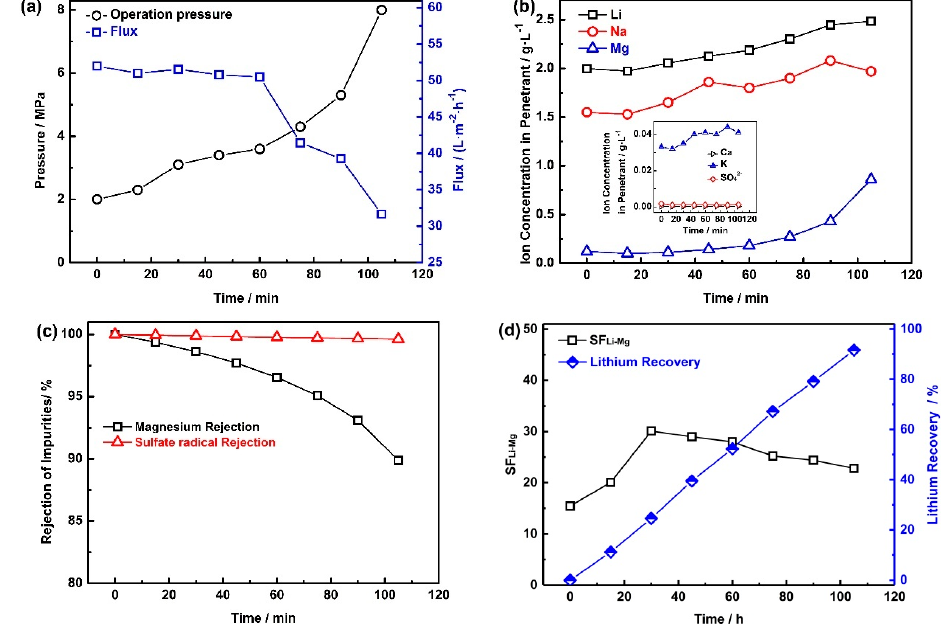
Figure 3. The NF process for purification. ( a ) The relationship of the operation pressure and the flux of the membrane; ( b ) concentration of Li + , Na + , K + , Mg 2 + , Ca 2 + , and SO 42 − in the permeate flow; ( c ) the rejection rate of Mg 2 + and SO 42 − ; ( d ) the recovery of lithium and the separation factor of lithium and magnesium (SFLi-Mg). Table 3. The main analytical results in the collected retentate during the nanofiltration (NF) process. Time Conductivity T